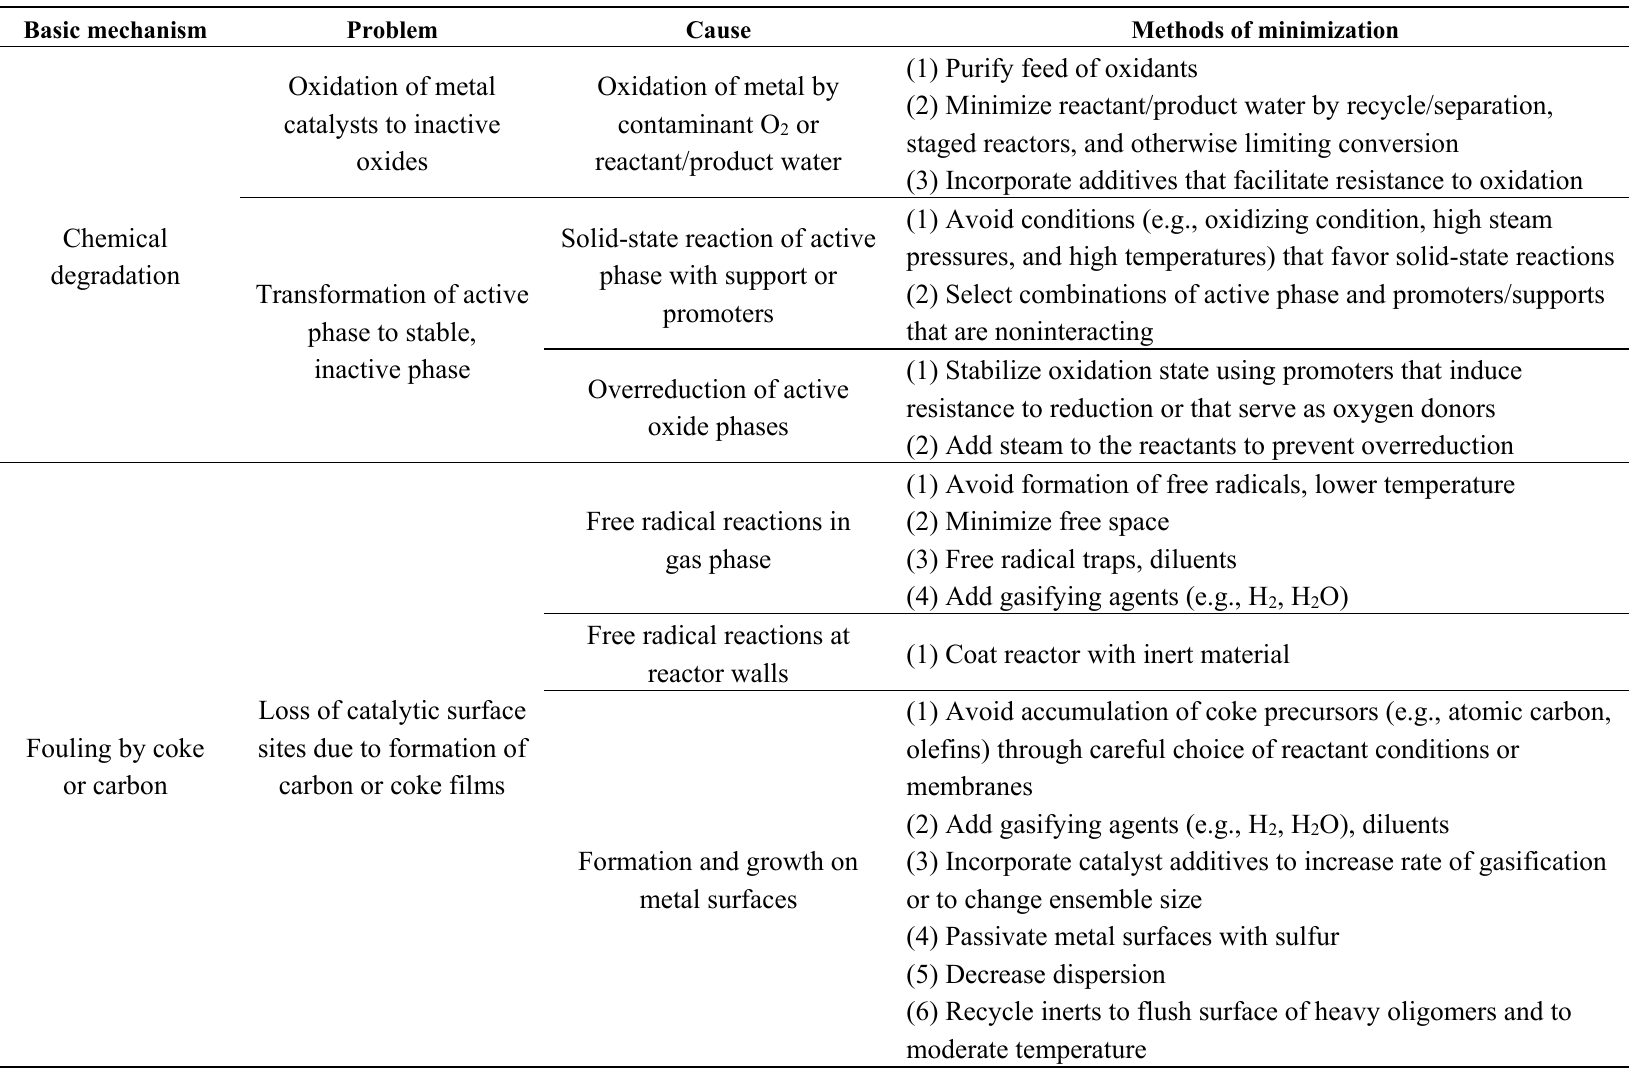
Table 18. Methods for Preventing Catalyst Decay